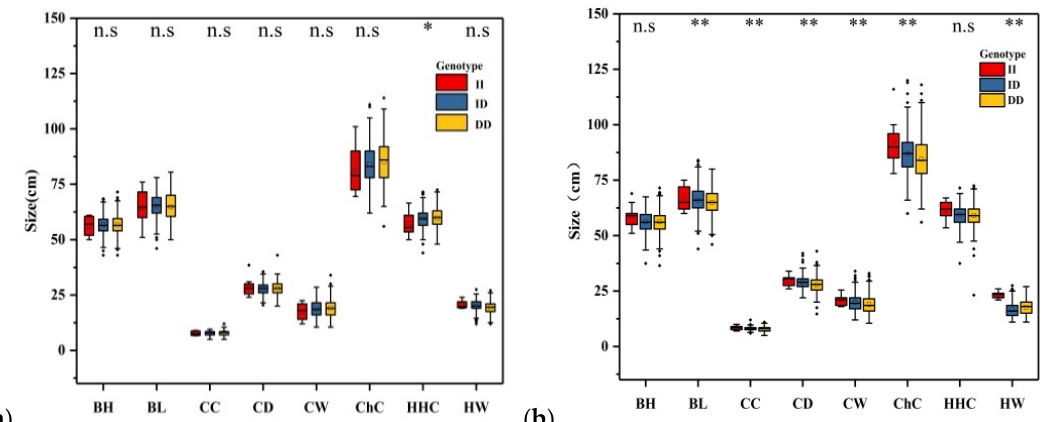
Figure 4. Relationship between P1–7 bp ( a ) and P2–13 bp ( b ) of the AKAP12 gene and growth traits in SBWC goats. Note: BH, body height; BL, body length; HHC, height at hip cross; ChC, chest circumference; ChD, chest depth; ChW, chest width; CC, cannon circumference. Significance results refer to two test methods. N·S means not significant; * p < 0.05 and ** p < 0.01.